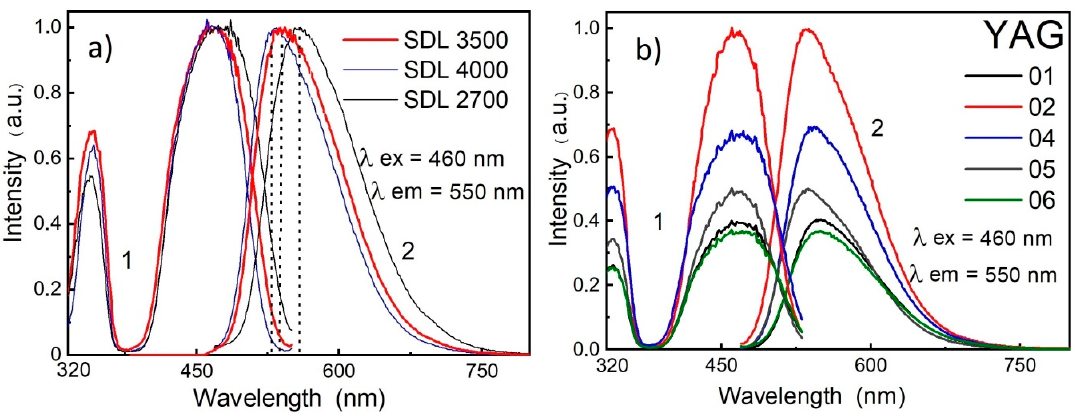
Figure 2. Spectra of excitation (1) and luminescence (2) in SDL ( a ) and C-YAG phosphors ( b ).